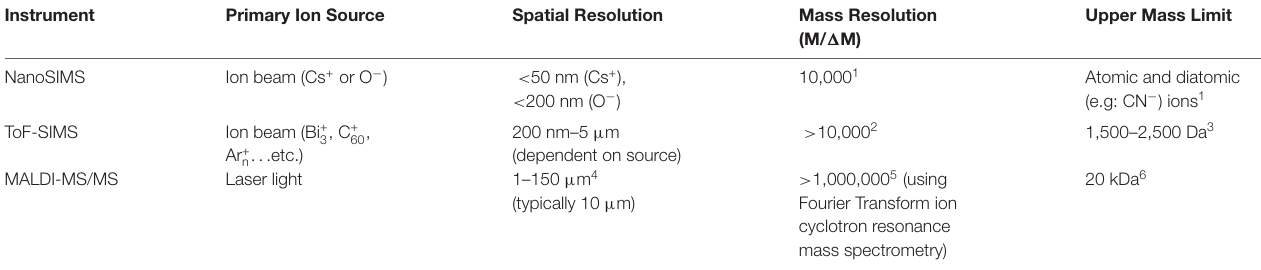
TABLE 1 | Comparison of secondary ion mass spectrometry (SIMS) techniques with other mass spectrometry imaging techniques.